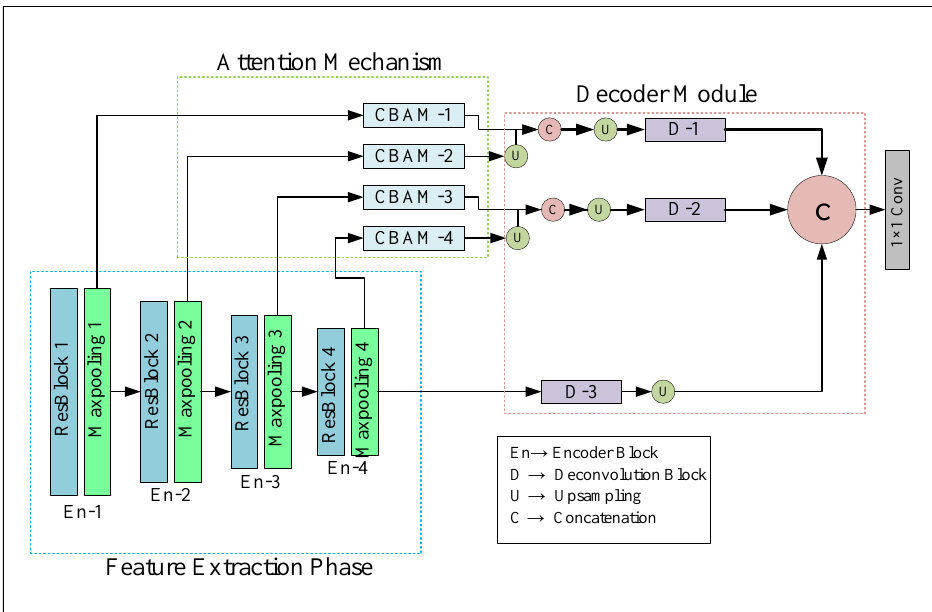
Figure 1. Structure of the Proposed LLDNet architecture. Our code is available at https://github. com/Masrur02/LLDNet (accessed on 21 June 2022).